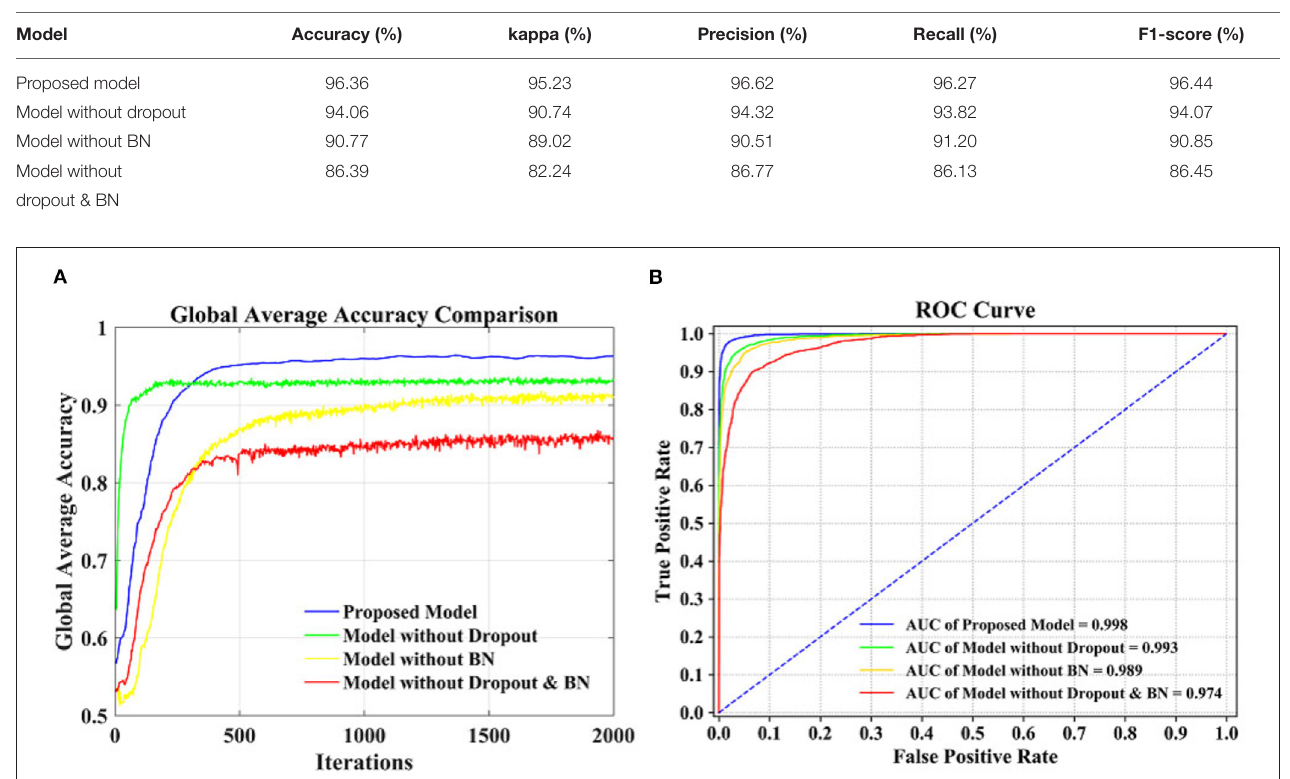
TABLE 3 | Performance comparison of different convolutional neural network (CNN) models.